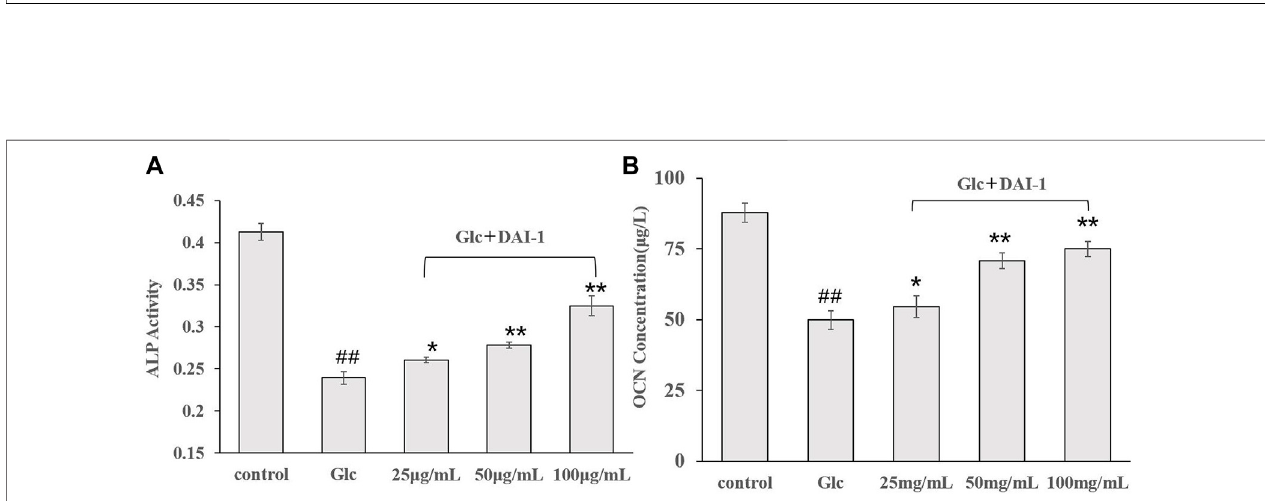
FIGURE4| The effects ofDAI-1onalkaline phosphatase(ALP) (A) and osteocalcin (OCN) (B) inosteoblastsexposedtohighglucoseconcentrations. Osteoblasts wereculturedindifferentconditionedmediafor48 h,followingwhichALPandOCNactivitiesweredetermined. ## : p < 0.01,forhigh-glucosegroup vs .thecontrolgroup; *: p < 0.05, **: p < 0.01, for the DAI-1and DAI-2 treated group vs . high-glucose group.